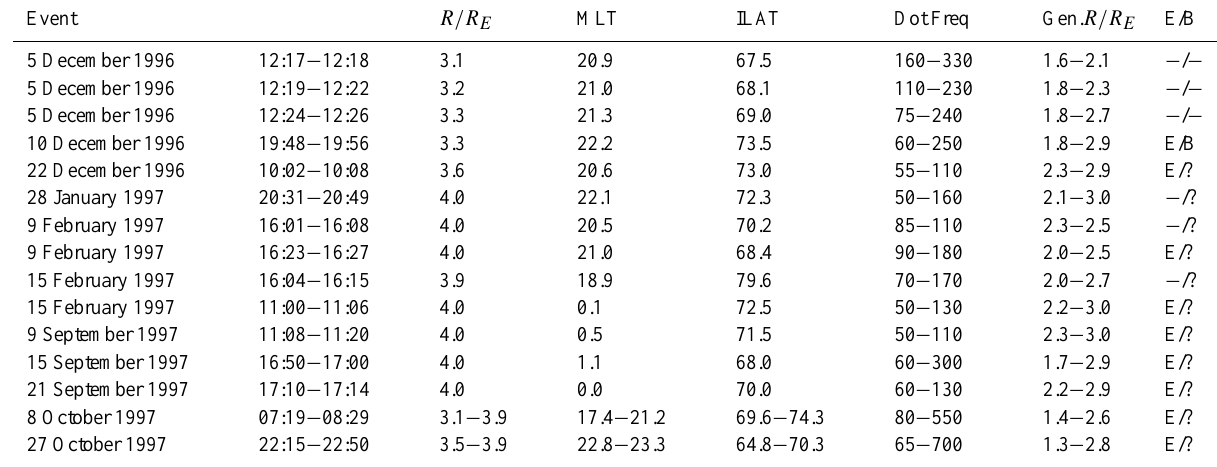
Table 2. Interball SLFAKR